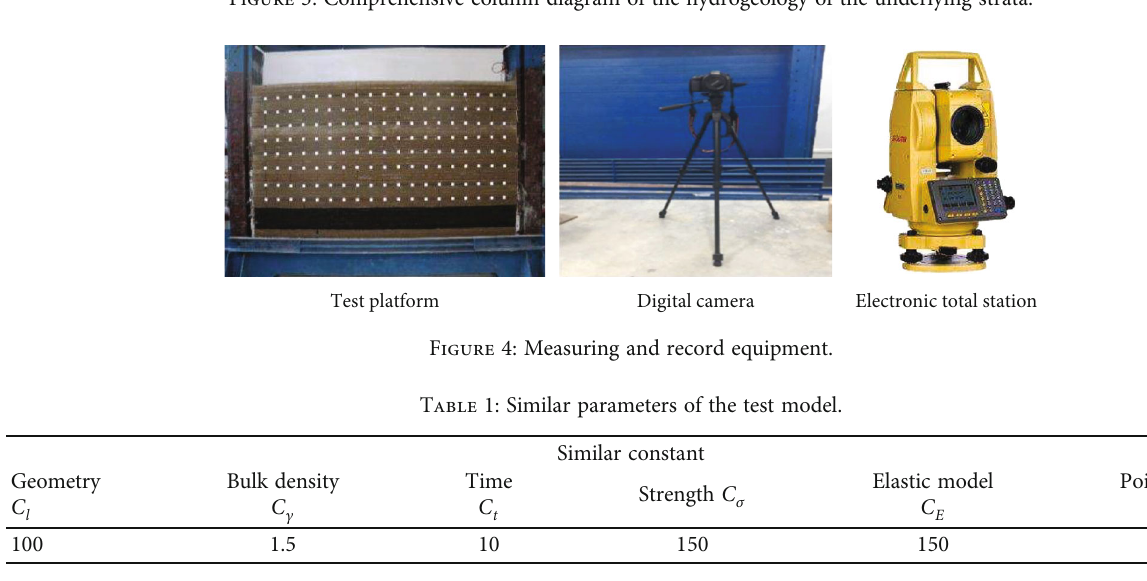
Figure 3: Comprehensive column diagram of the hydrogeology of the underlying strata.